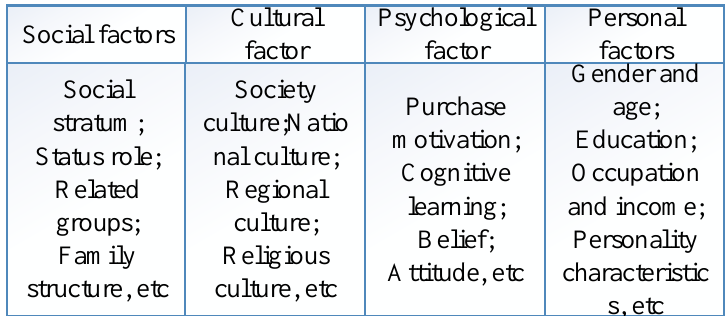
Figure 6. Influencing Factors of Consumer Buying Behavior.